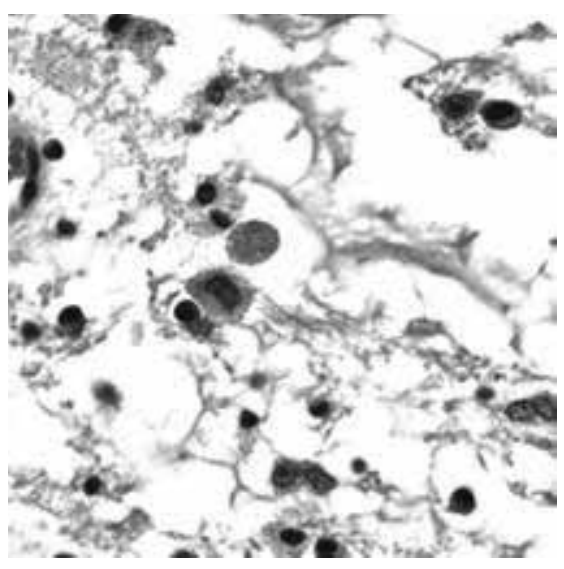
figurE 1 – Ganglion cell in pilocytic astrocytoma (HE, lens 40×) HE: hematoxylin and eosin.